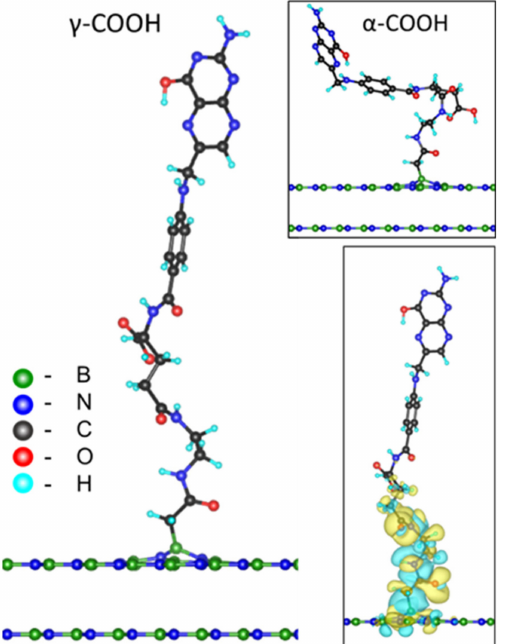
Figure 7. Schematics of FA / EDA-BNNPs PT ( γ -COOH). Top inset: another possible but energetically unfavorable type of bonding between EDA-BNNPs PT and carboxyl groups of FA ( α -COOH). Bottom inset: distribution of spatial charge density di ff erence between FA / EDA-BNNPs PT ( γ -COOH) and corresponding freestanding parts. The loss and gain of charge are denoted by yellowish and bluish colors, respectively. The boron, nitrogen, carbon, oxygen, and hydrogen atoms are marked by green, blue, gray, red, and cyan colors,